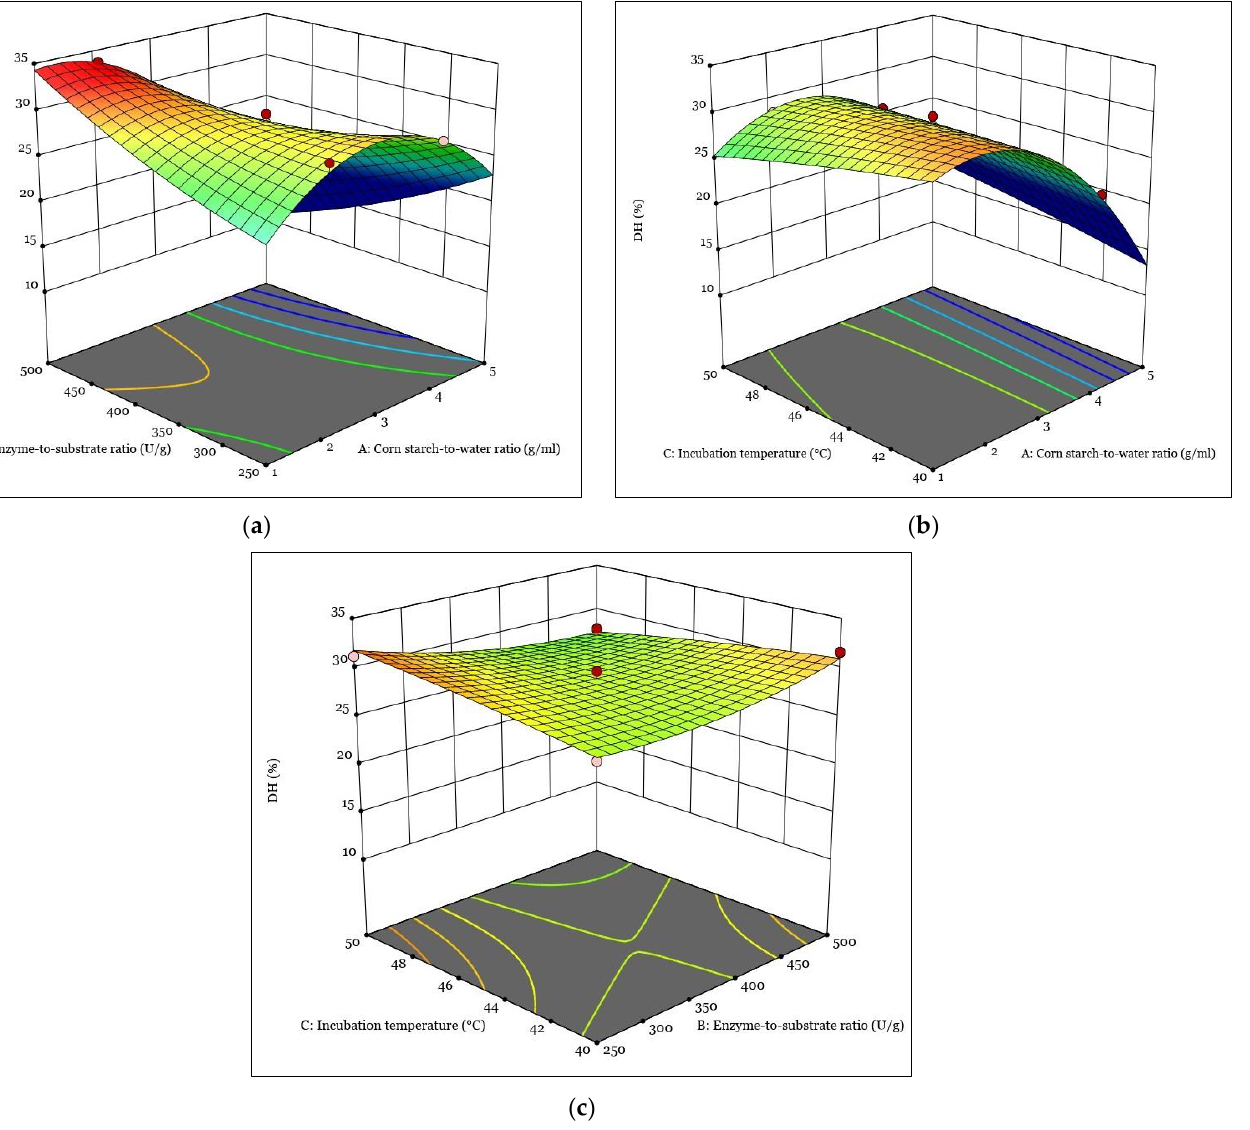
Figure 1. The response surfaces plots of the quadratic and 2FI polynomial models representing the influence of the interaction between independent variables on the DH: ( a ) interaction between A and B; ( b ) interaction between A and C; ( c ) interaction between B and C.